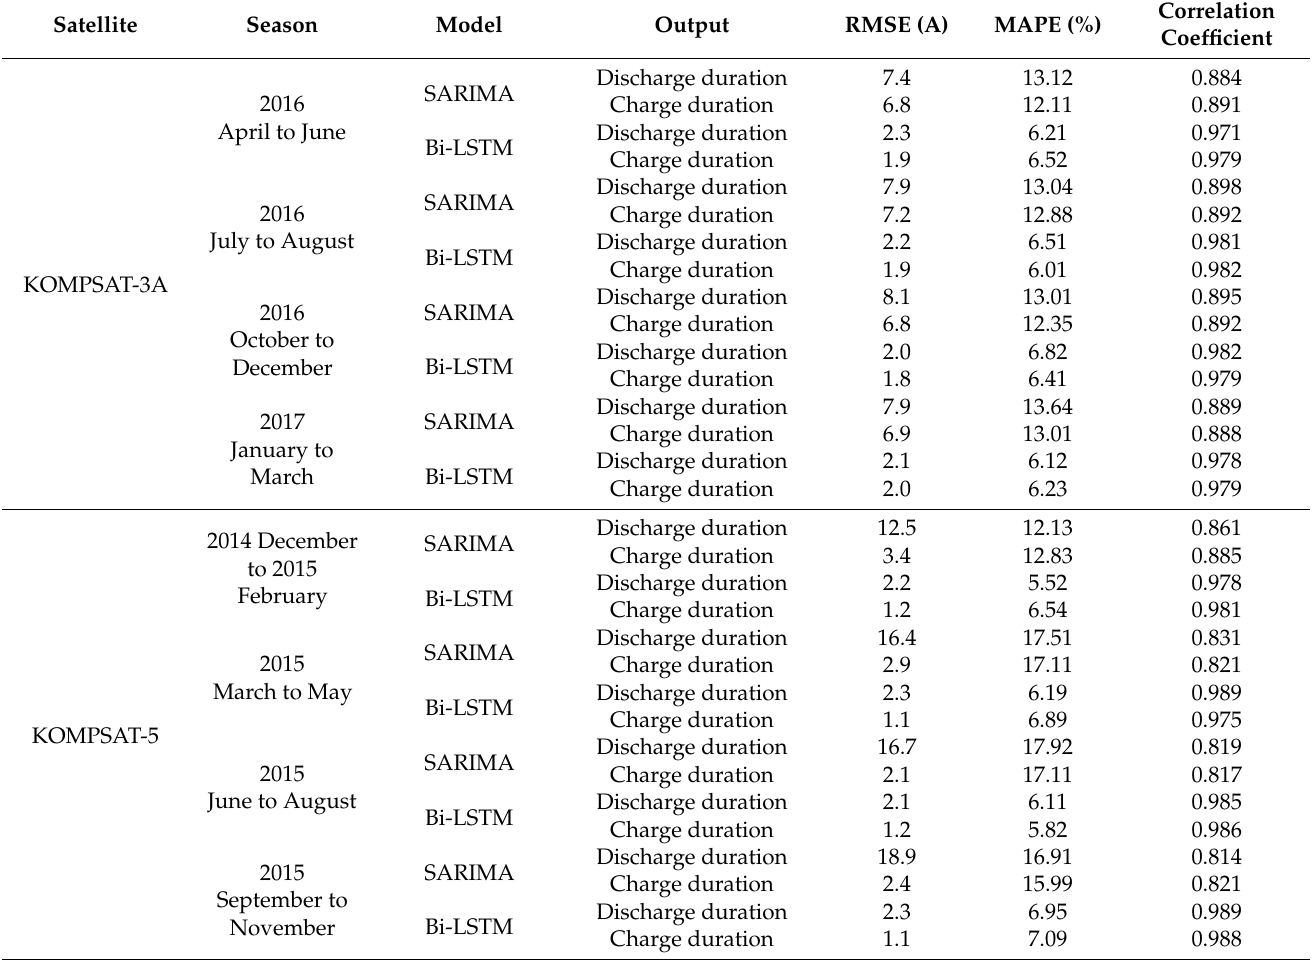
Table 2. The 12 h ahead prediction